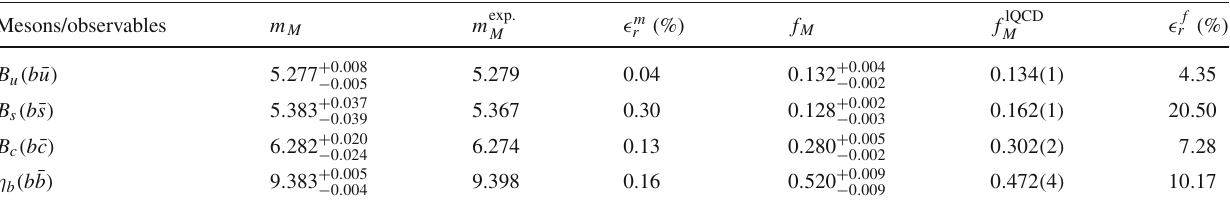
Table 4 Masses and decay constants (in GeV) of the B mesons and η b calculated with the hybrid approach of using a 2ccp representation for the bottom quark and the numerical cp solutions for the u , s and c quarks. Experimental masses are taken from the Particle Data Group